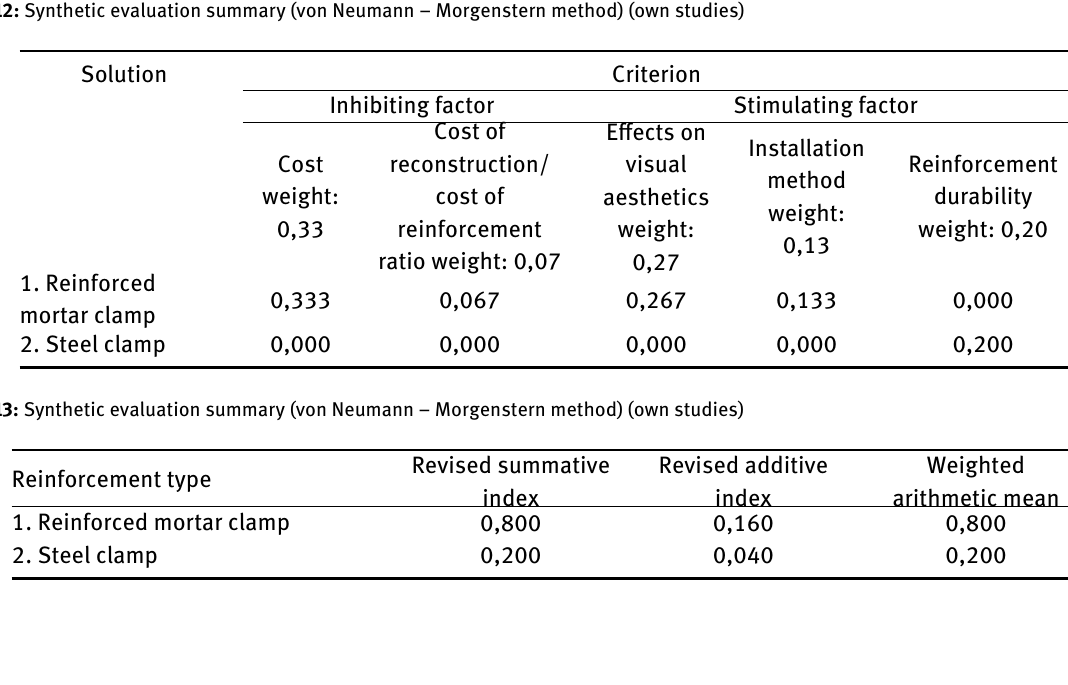
Table 12: Synthetic evaluation summary (von Neumann – Morgenstern method) (own studies)